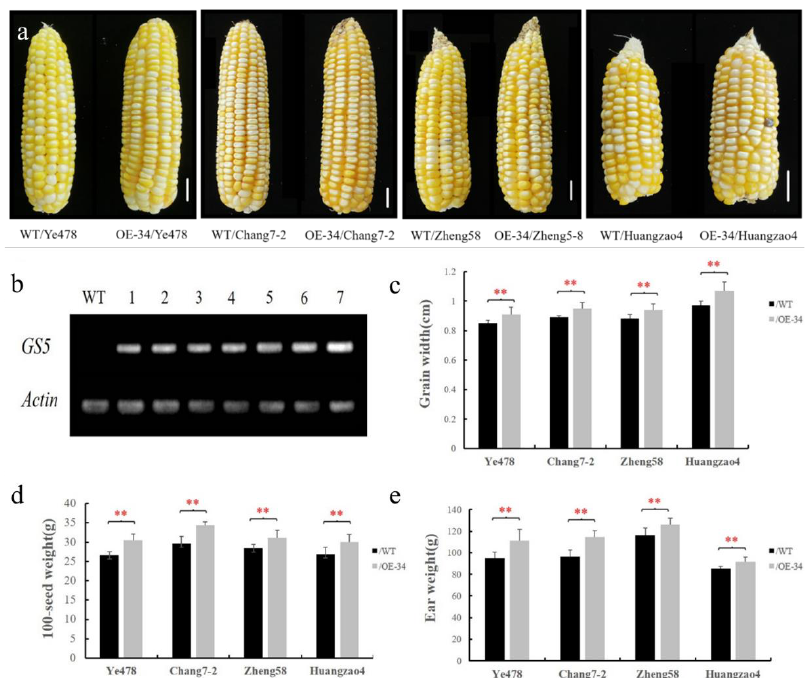
Figure 5. Evaluation of yield-related traits in GS5-OE-34 hybrids. ( a ) Phenotypic plots of ears of F 1 -generation GS5-OE-34 hybrids. Scale bar, 2 cm. ( b ) GS5 expression levels in the F 1 generation of GS5-OE-34 and its corresponding wild type crossed with Ye478, Zheng58, Chang7-2, and Huangzao4. ( c – e ) Phenotypic analysis of kernel width, 100-kernel weight, and ear thickness in hybrids. Bar indicates means, and error lines represent standard deviations. ** represents a significant difference at p < 0.01.